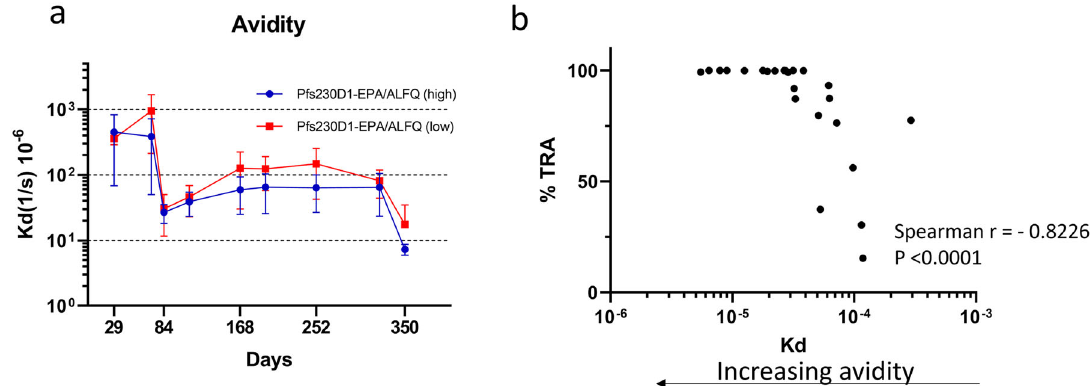
Fig. 5 Avidity increased with repeated vaccinations. a Antibody avidity, presented as dissociation constant KD, of sera from animals immunized with high (blue) or low (red) dose of the Pfs230D1-EPA conjugate at different time points during the study. Group size = 5. Each point represents the mean value for the group and error bars represent the standard deviation. b Correlation between antibody avidity and functional activity (%TRA) of sera from day 84, d168 and d350. Points represent KD for each monkey. Spearman r = − 0.8226; p <